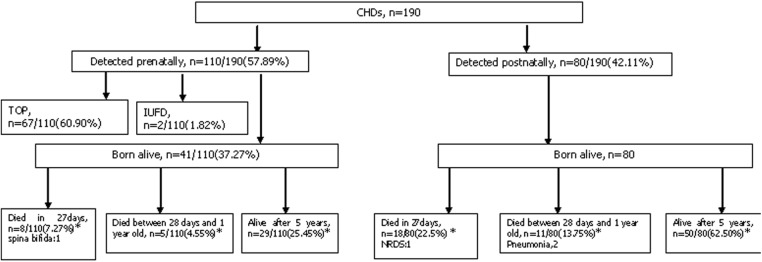
Outcomes and prognosis of infants with CHDs detected either prenatally or postnatally.*P<0.001.